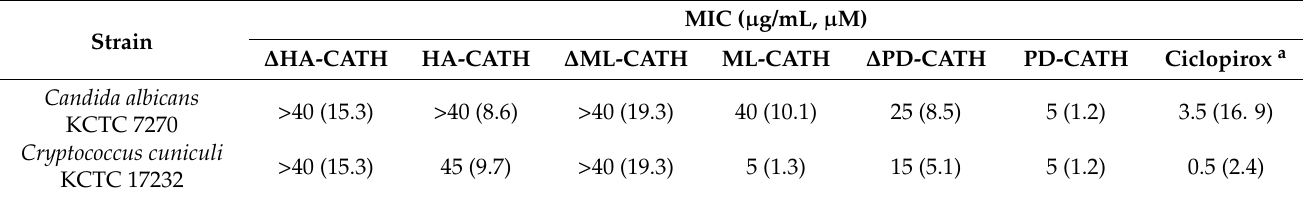
Table 3. Minimum inhibitory concentrations of six bat cathelicidin-derived peptides against two yeast form fungal